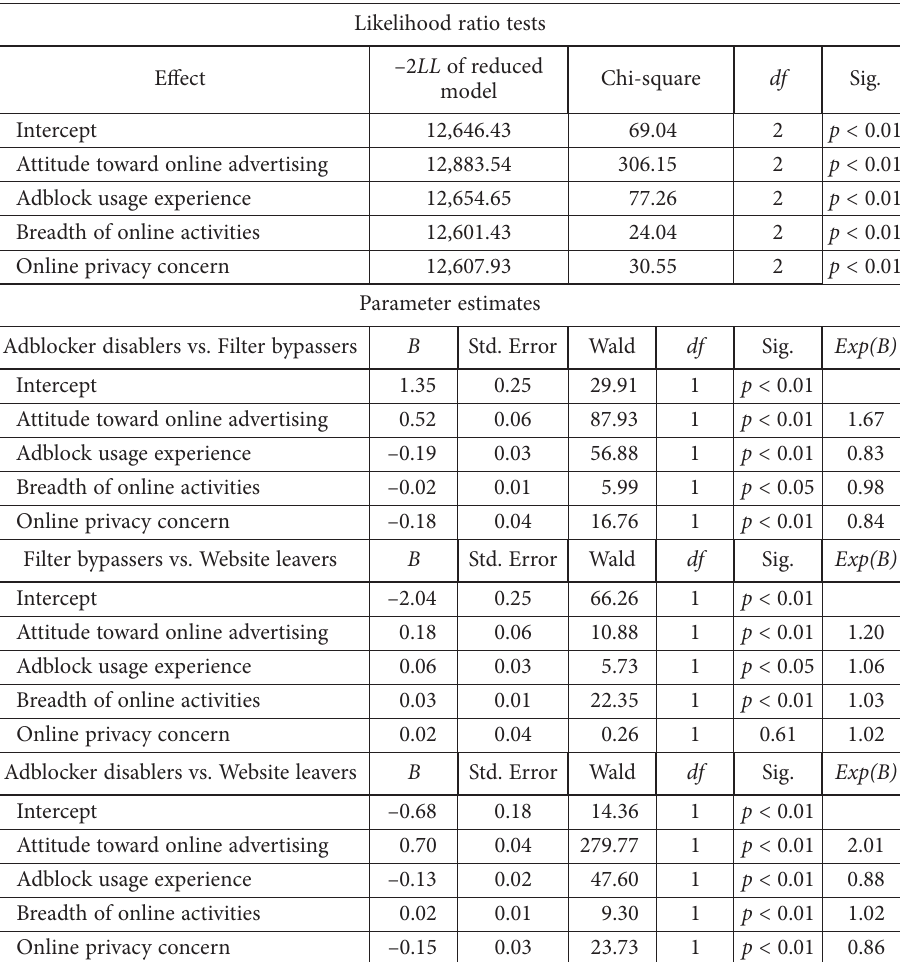
Table 2. Multinomial logistic regression for responses to anti-adblock filters (N =